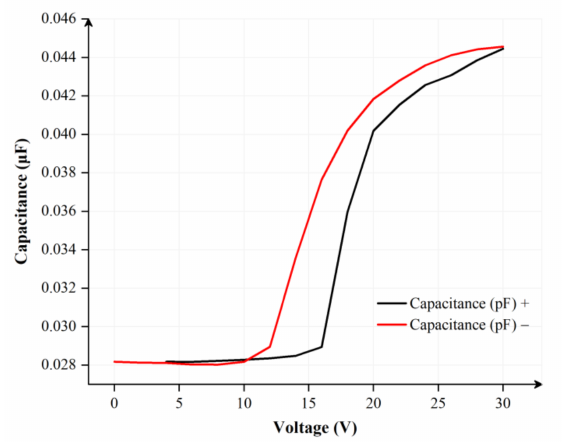
Figure 2. The C-V curve of EFDs within 500 ms. The voltage change rate was ± 0.06 V/ms. There was a significant hysteresis between two C-V curves for positive and negative